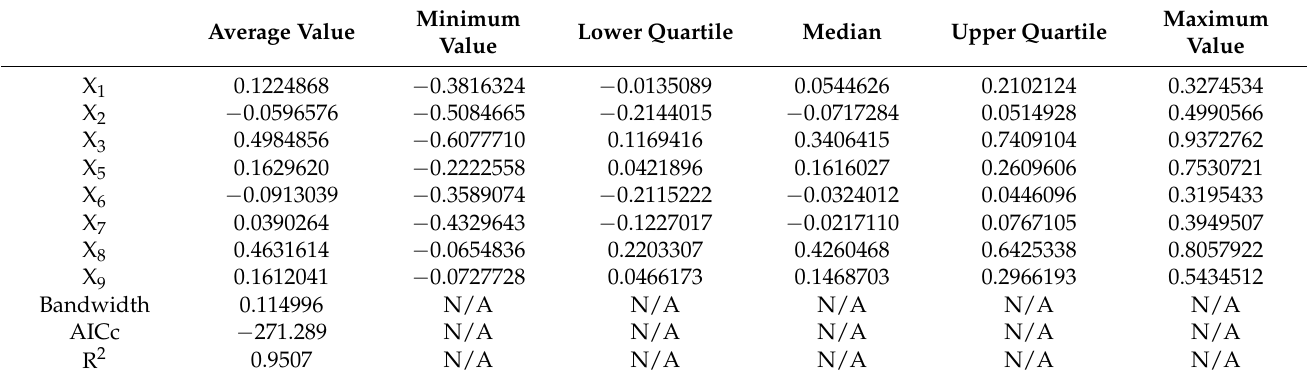
Table 5. Statistics of the effect of explanatory